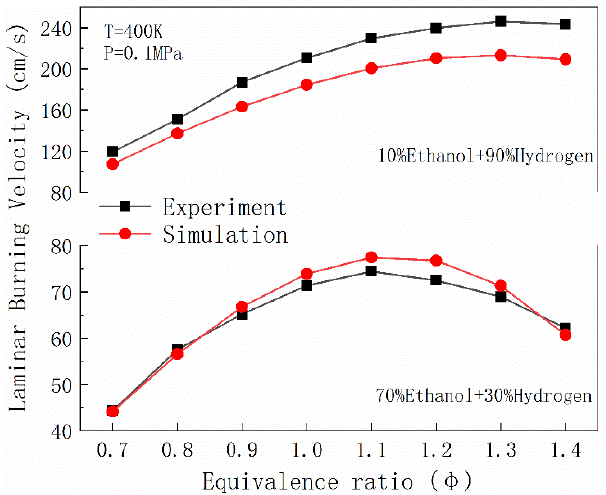
Figure 4. Comparison of LBVs obtained by simulation and experiment: T0 = 400 K and P0 = 0.1 MPa, with a hydrogen composition of 30% and 90%.